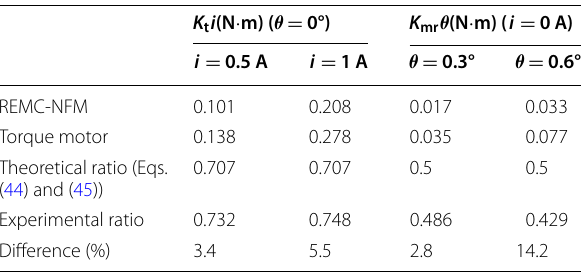
Table 8 Comparison of output torques between REMC-NFM and torque